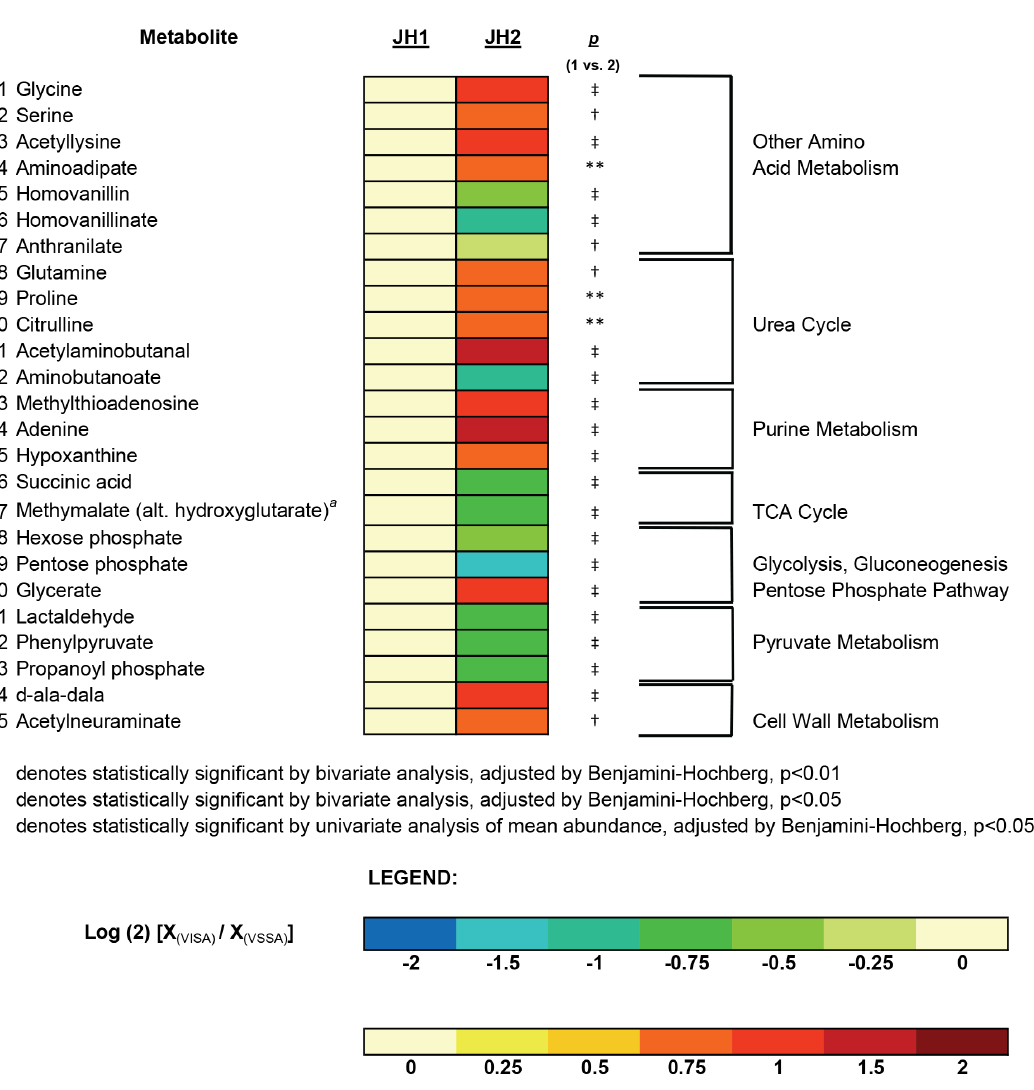
Figure 3. Heat map of Altered Metabolites in the VISA, JH2, Versus its Parent VSSA, JH1. Heat map displaying the 25 metabolites whose abundance was significantly altered in the VISA isolate, JH2, compared against its parent VSSA, JH1. Changes in abundance are indicated by color coding with red indicative of increases in mean intracellular abundance relative to the baseline (defined by the abundance in JH1) and blue indicative of decreases in intracellular abundance on a log (2) scale. Specific p -values for the comparison of JH2 versus JH1 are denoted to the near right of the heat map. Metabolites are grouped according to pathway, denoted to the far right of each metabolite. The superscript ( a ) denotes unable to determine if methylmalate or hydroxyglutarate in the absence of a chemical